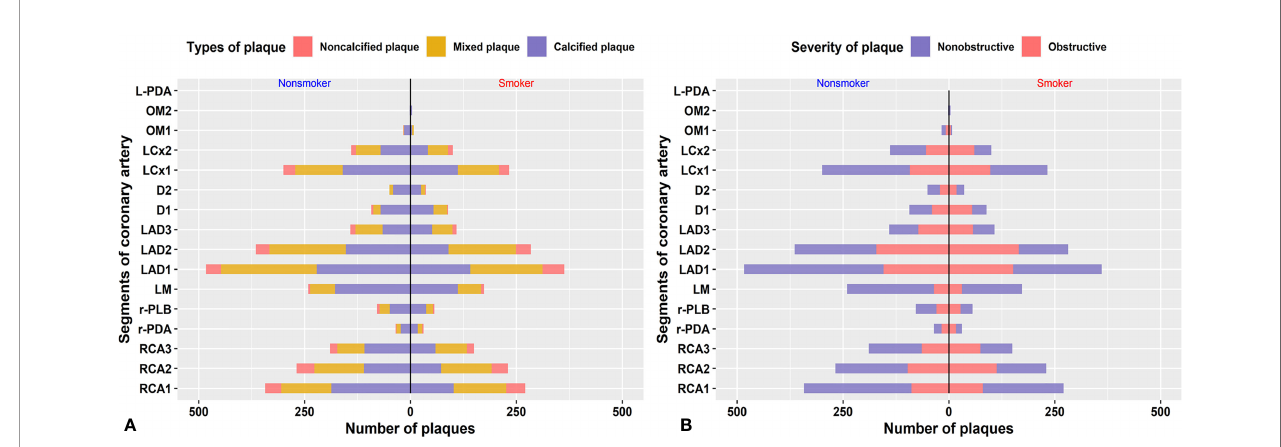
FIGURE 3 | Anatomical distribution of plaques. Distribution of different types of plaque (A) and grade of stenosis (B) caused by plaque in each segment of the